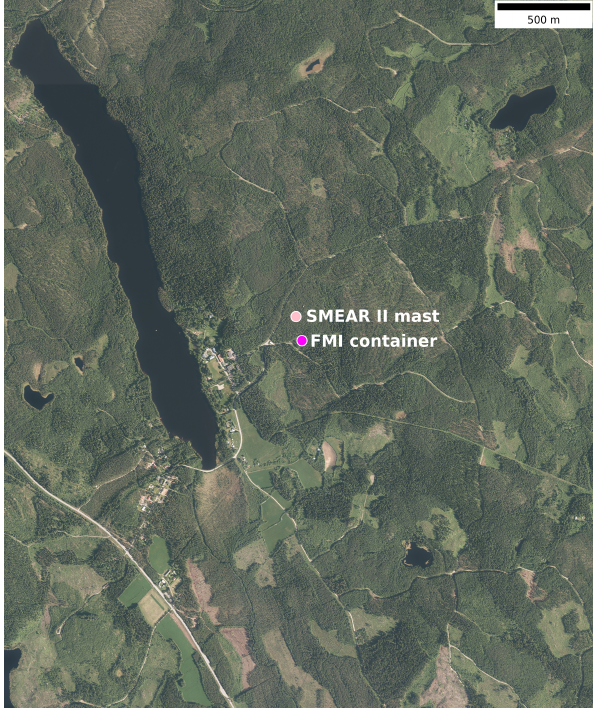
Figure 1. Orthophotograph of the SMEAR II station in Hyytiälä and its surroundings with the marked location of the station mast and the container where the measurements were performed. (Source: Land Survey of Finland Topographic Database